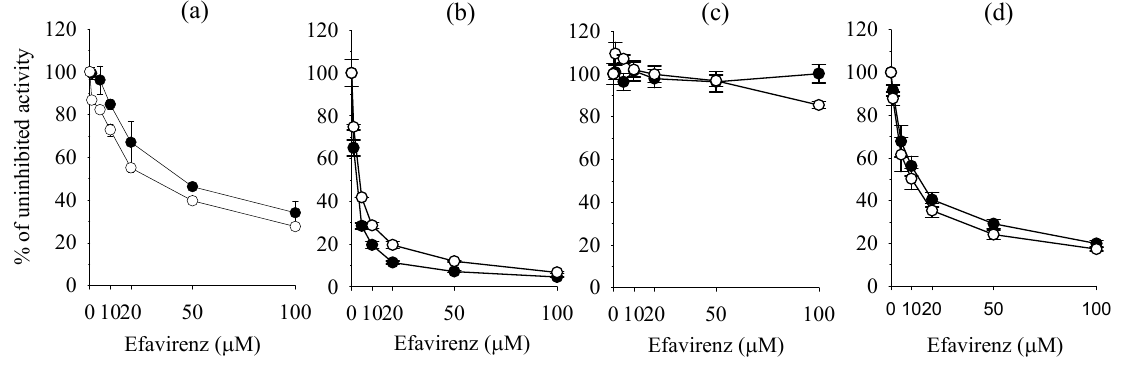
Figure 2. Representative Dixon plots for inhibitory effects of efavirenz on ( a ) UGT1A1-catalyzed 17  -estradiol 3-glucuronidation; ( b ) UGT1A4-catalyzed trifluoperazine N -glucuronidation; and ( c ) UGT1A9-catalyzed propofol glucuronidation in pooled human liver microsomes H161.